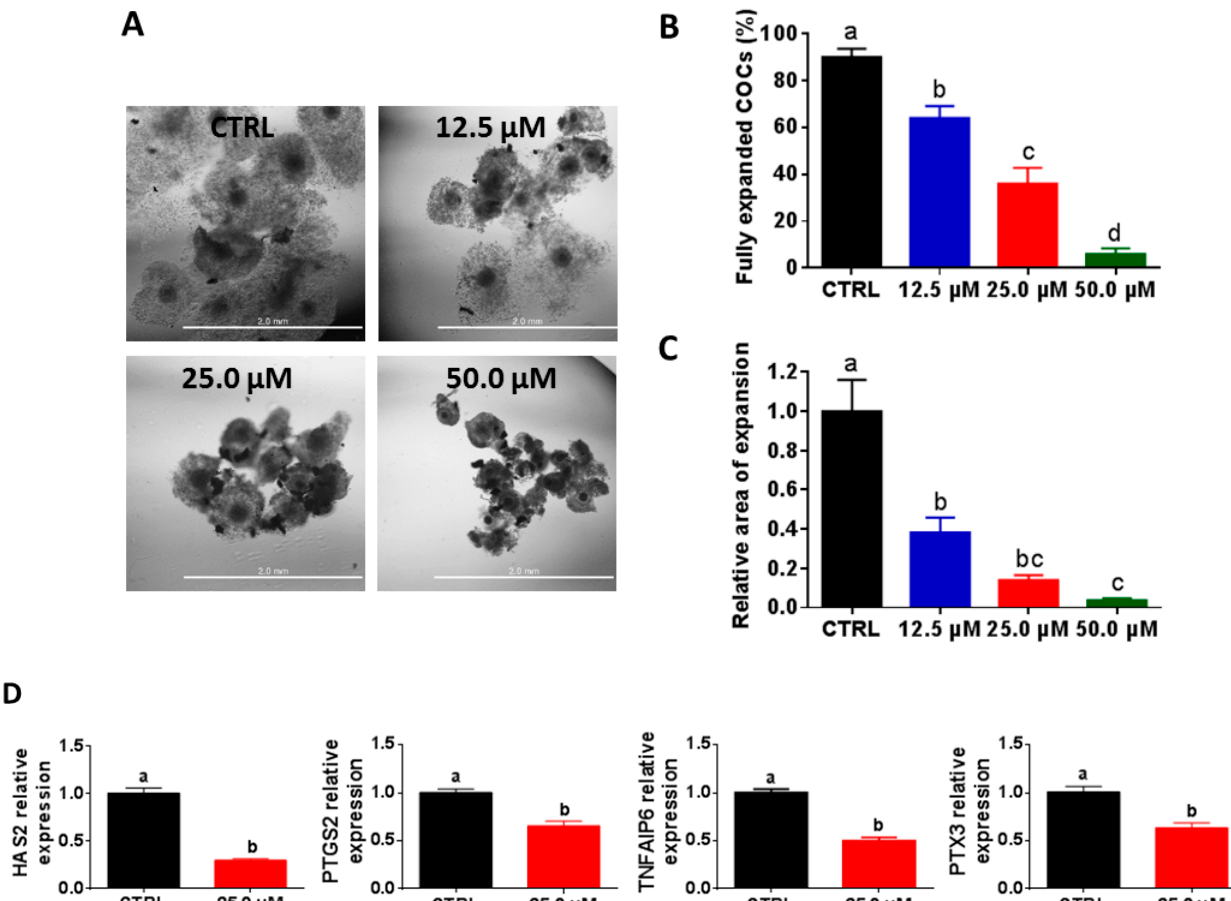
Figure 1. Cumulus expansion patterns following juglone treatment. ( A ) Morphological appearance of cumulus–oocyte complexes (COCs) after maturation. ( B ) The percentage of COCs with fully expanded cumulus cells. ( C ) The relative change in COCs expansion area. ( D ) Investigation of the relative expression of expansion-specific genes using RT–qPCR. Scale bar = 2.0 mm. Data are presented as mean ± SEM. The different letters on the columns reflect statistical significance ( p < 0.05).